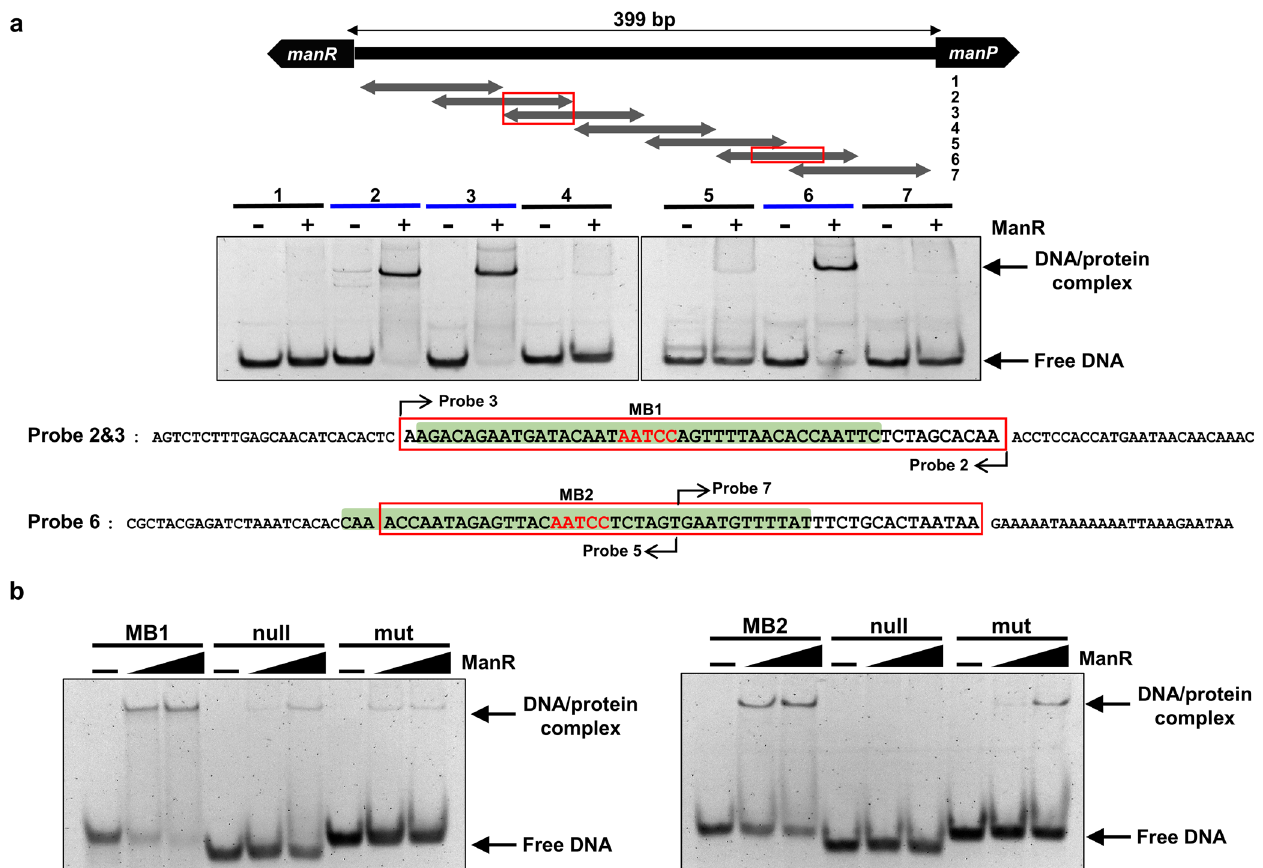
Fig. 3 The AATCC sequence in both ManR-binding sites is crucial for DNA binding of ManR. a EMSAs were performed using a series of 100- bp probes (represented by double-headed arrows with numbers), each having a 50-bp overlap with the next probe to identify the ManR binding region. Each probe (15 ng) was incubated with ( + ) or without ( − ) ManR (120 ng) and analyzed on a 14% polyacrylamide gel in TBE. Blue bars indicate the probes showing band shift, and red boxes indicate the overlapping region of probes 2 and 3 and the central region of probe 6, respectively, the sequences of which are shown below. b To determine whether the AATCC sequence is crucial for ManR binding, EMSAs were performed using the 39-bp probes (highlighted in green in a encompassing the AATCC sequences and mutated probes where the AATCC sequence was removed (null) or replaced with CACTA (mut). Each probe (8 ng) was incubated with increasing amounts of ManR (0, 60, and 120 ng) and analyzed on a 14% polyacrylamide gel in